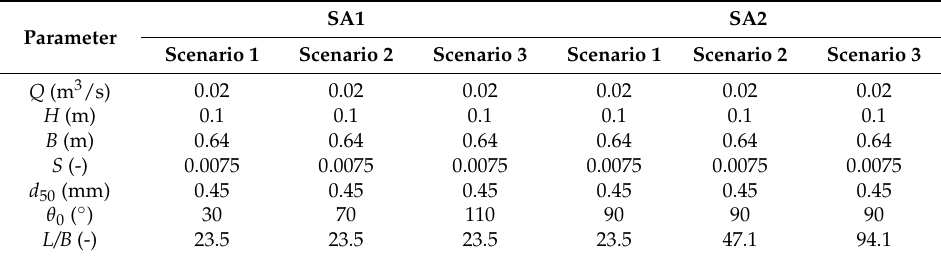
Table 1. Computational parameters used in the sensitivity analysis. Q = discharge; H = flow depth; B = channel width; S = streamwise channel slope; d 50 = median particle size of the bed materials; θ 0 = maximum deflection angle; L/B = wavelength-to-width ratio ( L is the curve length of the channel within one meander